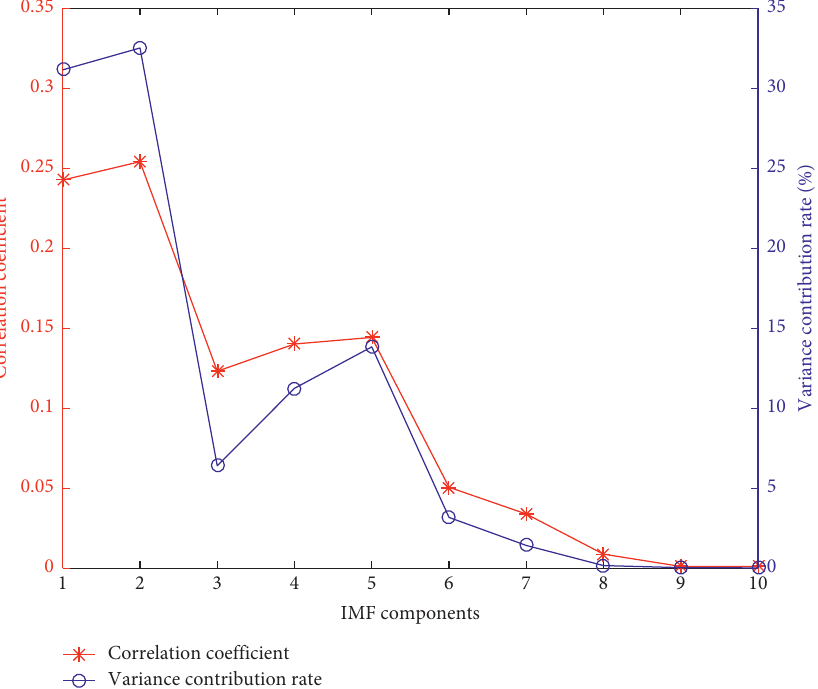
Figure 13: Correlation coefficient-variance contribution trend of the experimental outer ring fault mode.